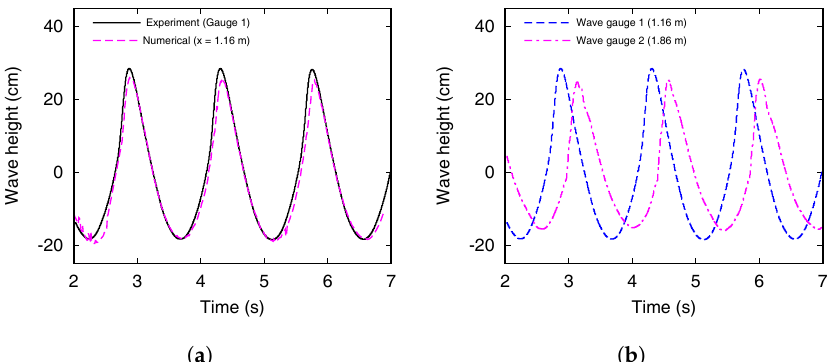
Figure 16. ( a ) Comparison of the wave heights in experiments and numerical simulations (Case VI-1). ( b ) Measured wave heights from the wave gauges 1 and 2 (Case